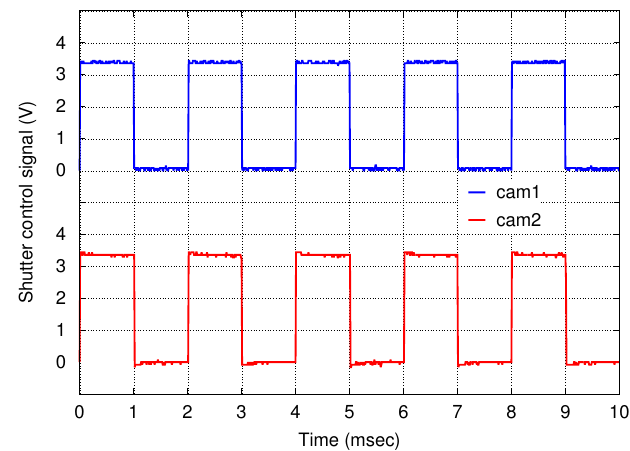
Figure 11. Shutter control signals of cameras 1 and 2, measured by a 2-channel oscilloscope at the same time. The down edges of the signals, which trigger the exposure of the cameras, are synchronized to within negligible errors of less than 10 µ s.